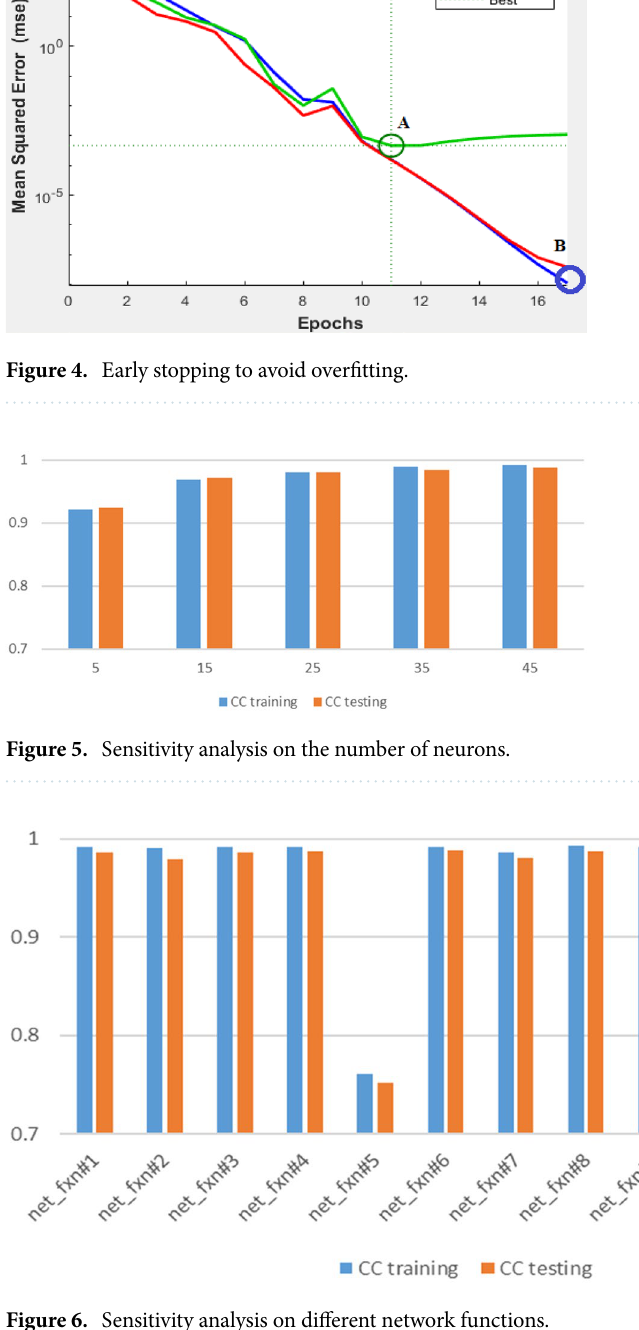
Figure 6. Sensitivity analysis on different network